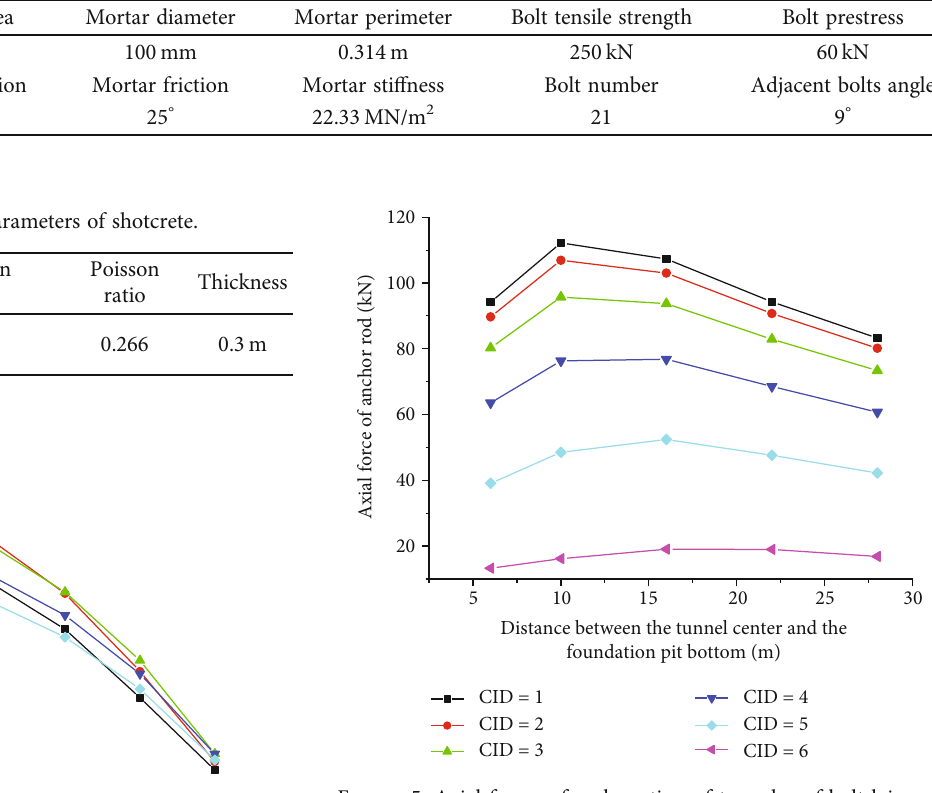
Figure 5: Axial forces of each section of tunnel roof bolt lying at di ff erent distances under foundation pit.